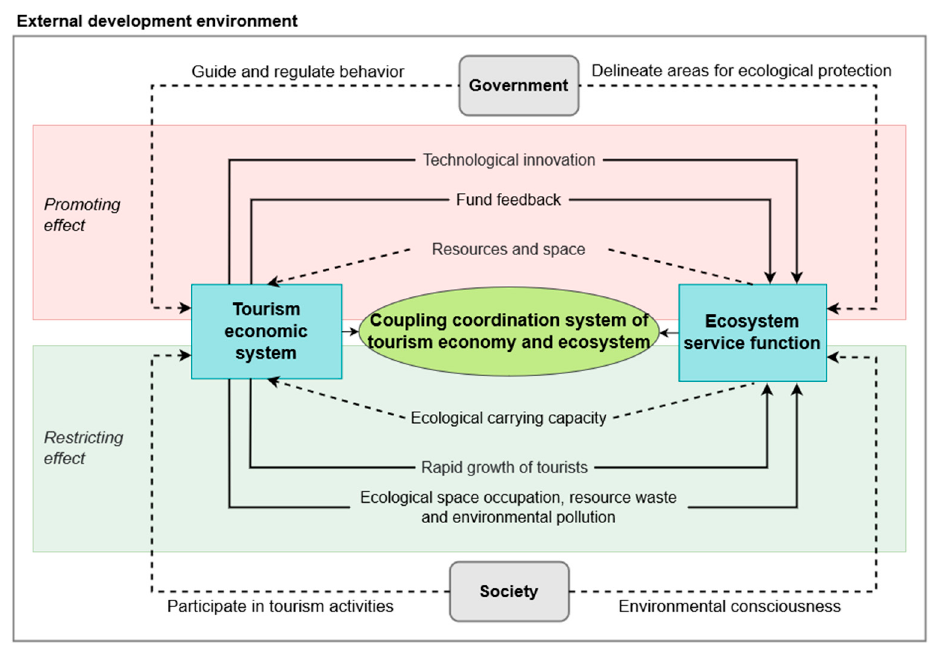
Figure 7. Coupling mechanism of tourism economic systems and ecosystem service function.